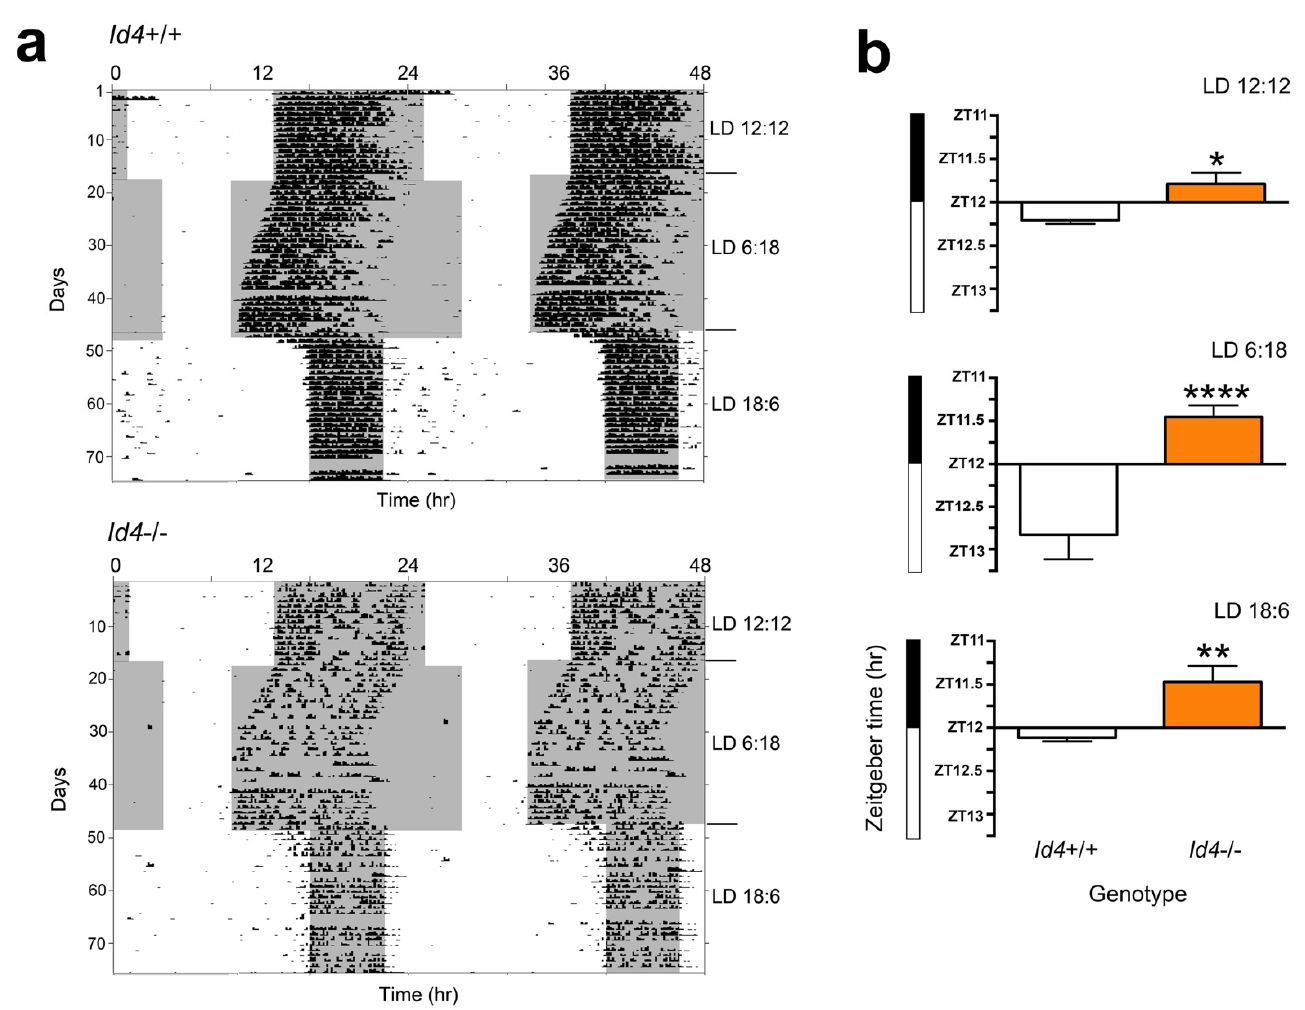
Figure 4. Id4 − / − mice show an advance in the phase angle of activity onset relative to lights off tested under 12:12 LD, 6:18 LD, and 18:6 LD photoperiods. ( a ) Wheel ‐ running locomotor activity records of wild ‐ type and Id4 − / − mice exposed to a 12:12 (standard) LD cycle for 1 month, transferred to 6:18 (short) LD cycle for another month, and finally exposed to an 18:6 (long) LD cycle for the remainder month of the experiment. The lines below each LD cycle on the right indicates the transition to each LD. The gray area indicates the dark period (scotophase) of each cycle. ( b ) Phase angle of activity onset to lights OFF (Zeitgeber time 12, ZT12) of wild ‐ type (white) and Id4 − / − mice (orange) on 12:12, 6:18, and 18:6 LD cycles. Values are group means ± SEM for wild ‐ type ( n = 20) and Id4 − / − ( n = 16) mice. Significant differences between genotypes were detected (* p < 0.05, ** p < 0.01, **** p < 0.0001).